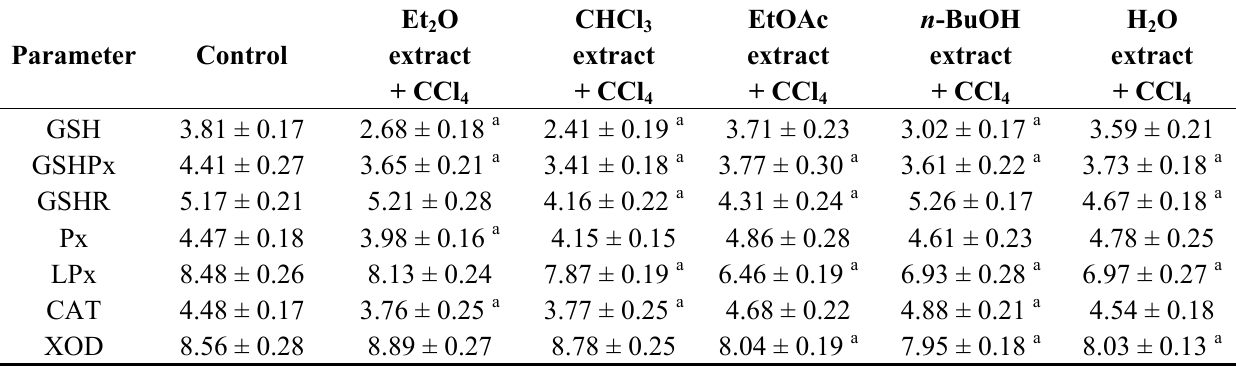
Table 5. Effect of T. pratense leaves extracts and CCl